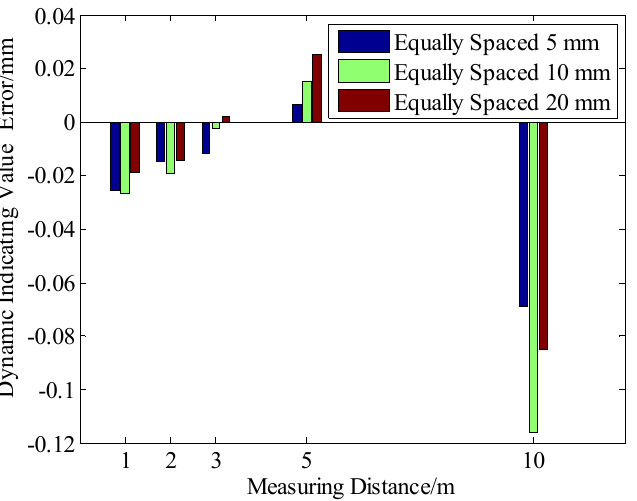
Figure 7. Measurement distance and dynamic display error diagram—(equally spaced). The value of the dynamic indication variable increases with the increase of the measure- ment spacing. Figure 8 shows the relationship between measured distance and dynamic indicating value error variate. Under the same distance, the dynamic indication variable is irregular when the measurement spacing set by the laser tracker increases. For instance, when the measurement distance is 1 m, and the equal spacing of the laser tracker is set to 5 mm, the dynamic indication variable is 0.00409 mm, and when the measurement distance is 2 m, the dynamic indication variable is 0.00462 mm. When the measurement distance is set to 3 m and the equal spacing of the laser tracker is 5 mm, 10 mm, and 20 mm, the dynamic indication variable is 0.01240 mm, 0.00615 mm, and 0.00995 mm, respec- tively.